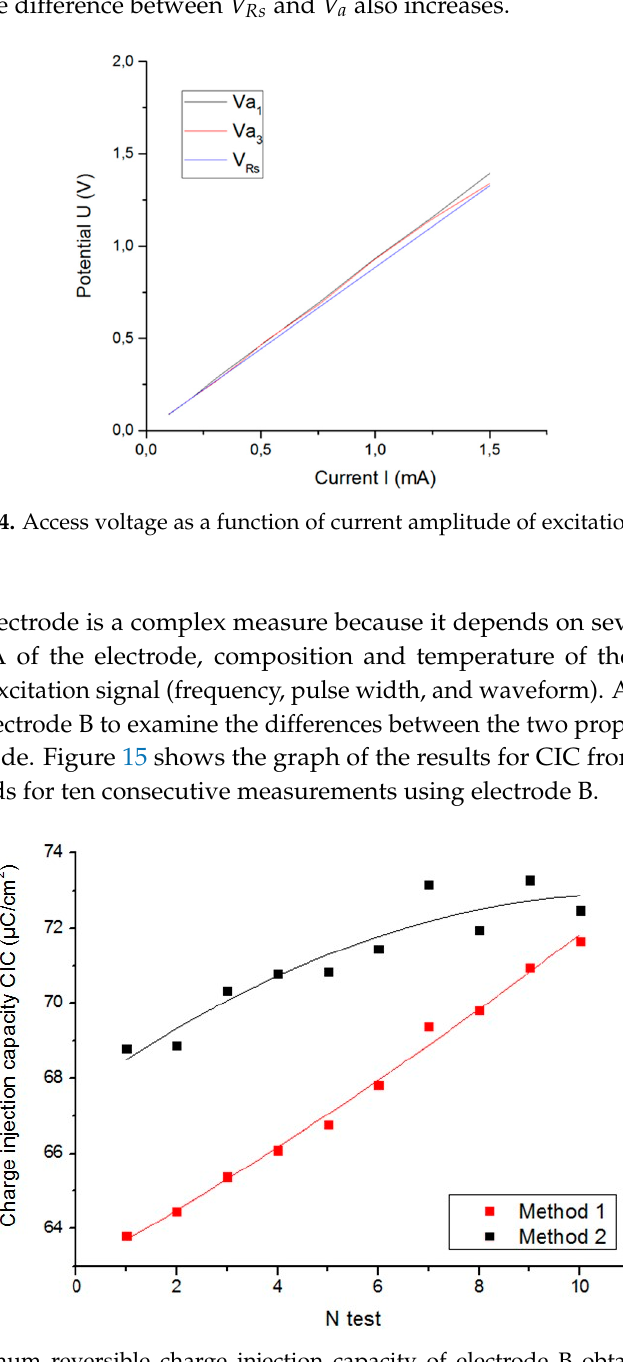
Figure 15. Maximum reversible charge injection capacity of electrode B obtained with N = 10 consecutive measurements. from ten consecutive measurements.